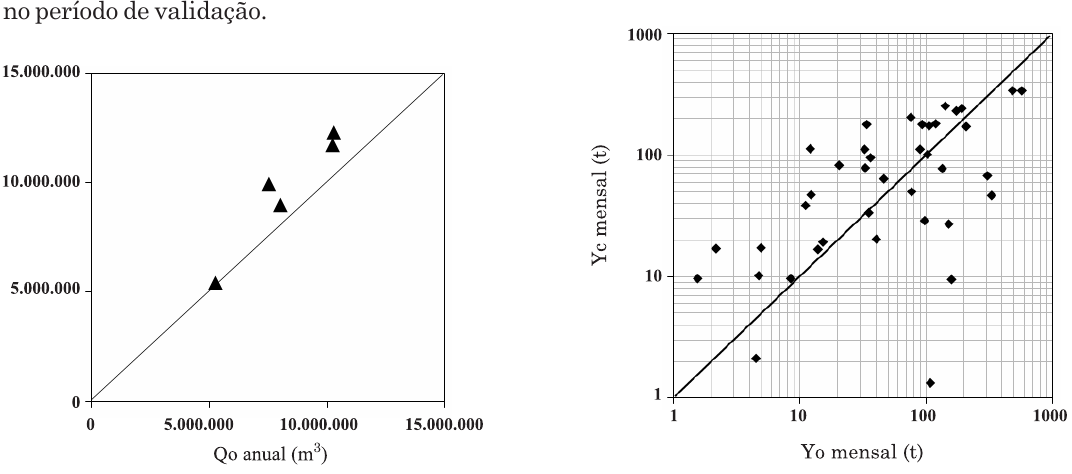
Figura 9. Valores mensais de aporte de sedimento observados e calculados na bacia do ribeirão Pipiripau, no período de